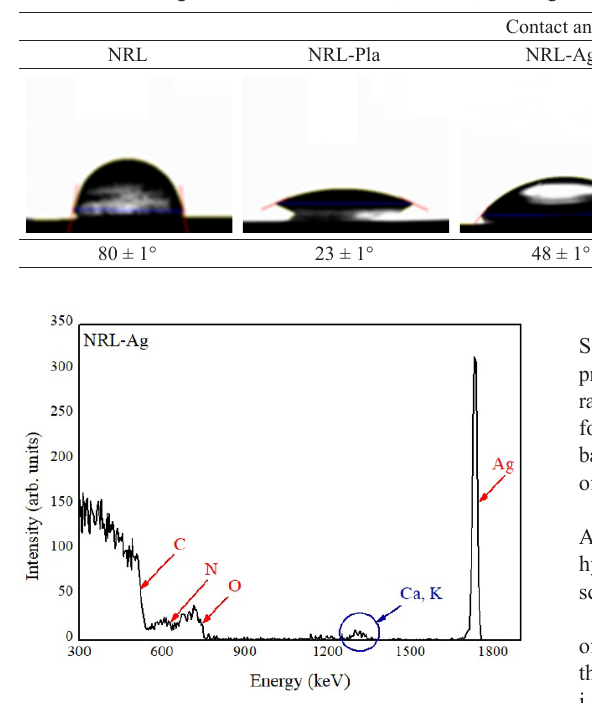
Figure 3. RBS spectrum of NRL-Ag film.